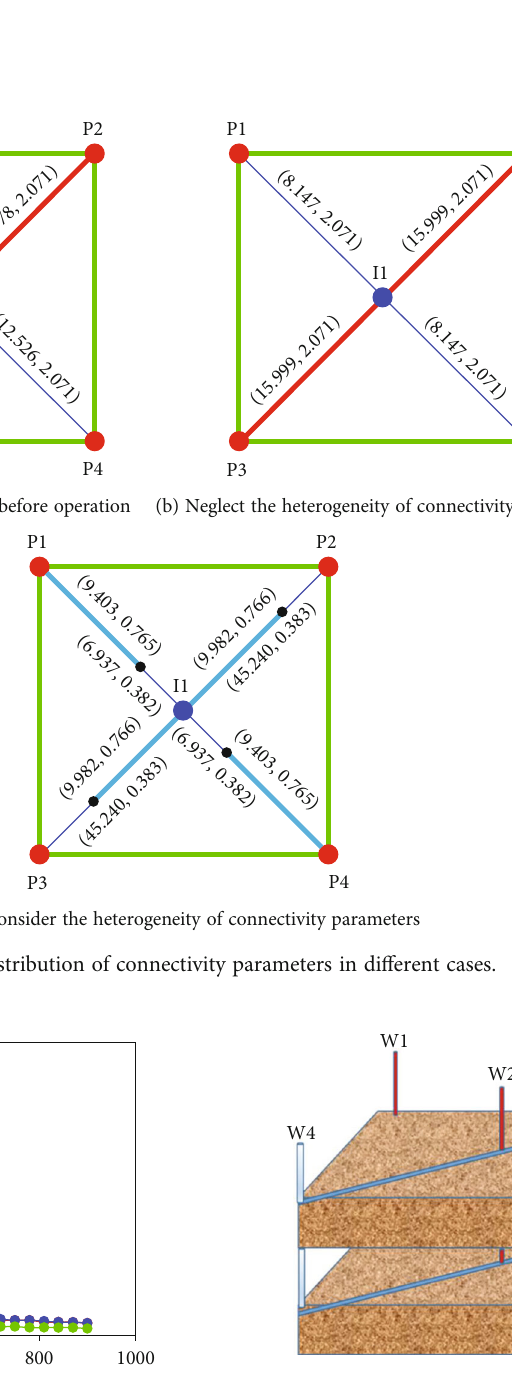
Figure 8: Schematic diagram of the heterogeneous physical model.